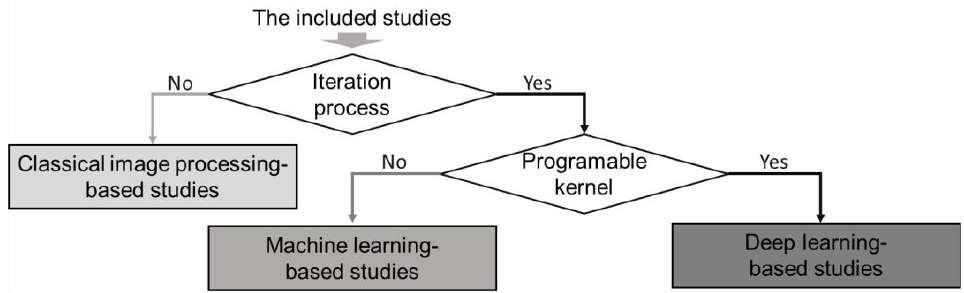
Figure 8. The classification rules of the proposed three categories for the included study (the classi- cal image processing-based study, the machine learning-based study, and the deep learning-based